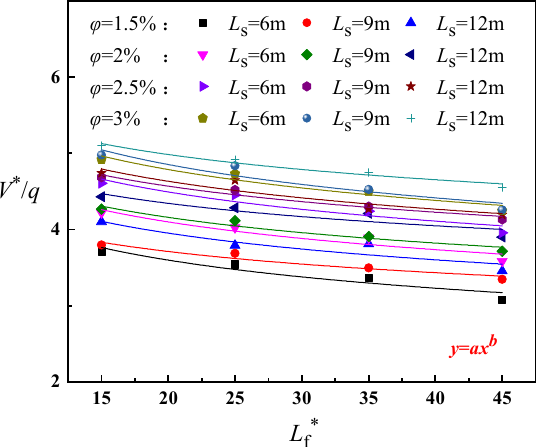
Figure 7. Dimensionless relationship between inlet air velocity and fire source location ( L f ≤ 330). In this paper, the HRR is constant, and Equation (5) can be simplified as: The dimensionless relations between inlet air velocity and fire source location are fitted, the fitting coefficients are shown in Tables 2 and 3. The average of the fitting curve coefficient is selected. When L f ≤ 330, V ∗ is positively correlated with ( L f ∗ )